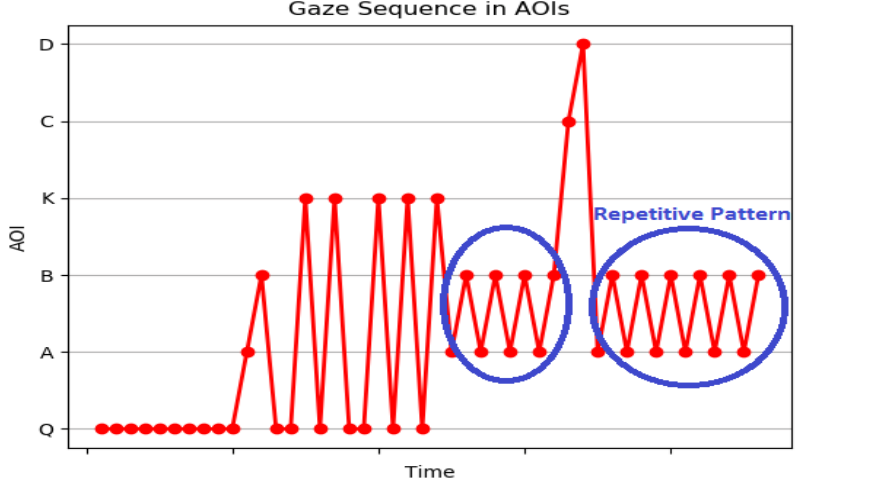
Figure 9. Gaze sequence plot representing WB of a underperforming learner where WB is observed between incorrect options.